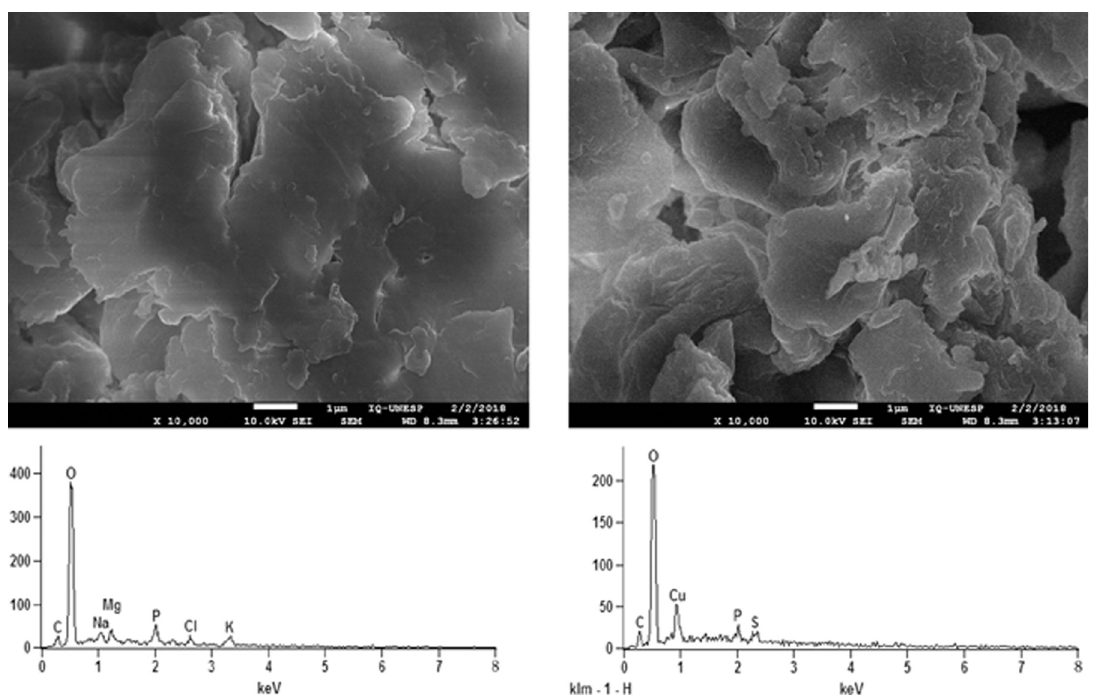
Fig 6. SEM images and EDXS spectra of fungal biomass. Photomicrograph of the surface of biomass before (A) and after (C) copper biosorption. Elementary analysis by EDXS of biomass before (B) and after (D) exposure to the metal.